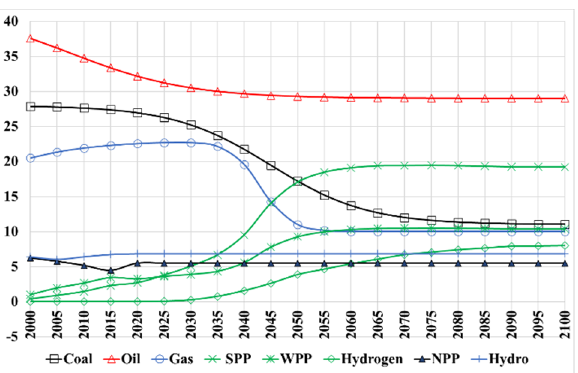
Energies 2021 , 14 , x FOR PEER REVIEW 18 of 26 Figure 19. The dynamics of changes in the structure of the world fuel and energy balance (shares in energy consumption) for the 21st century (conservative scenario) (for Coal, Oil, Gas, Solar Power Plants (SPP), Wind Power Plants (WPP), Hydrogen, Nuclear Power Plants (NPP) and Hydro energy).